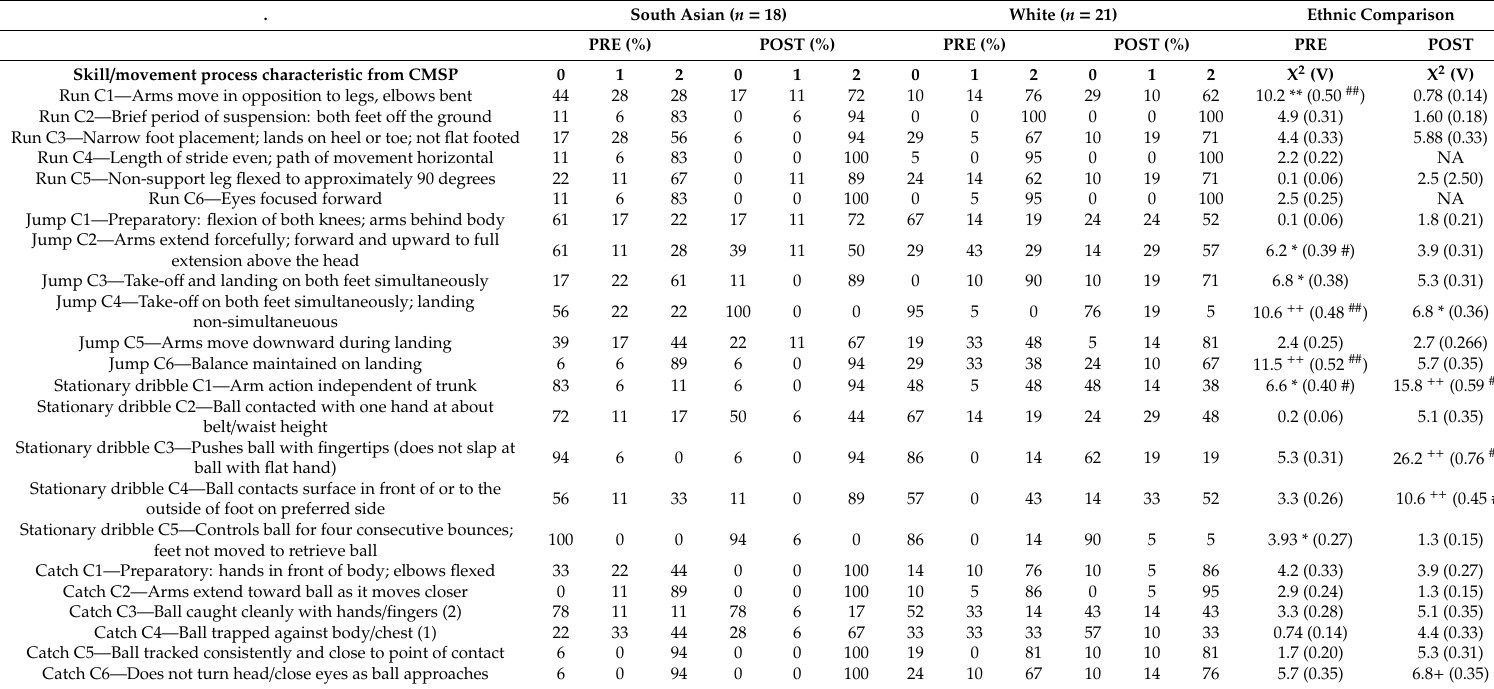
Table 5. Percentage of children at poor, near mastery, and mastery for each movement process characteristic of the skill at pre and post. . South Asian ( n = 18) White ( n = 21) Ethnic Comparison PRE (%) POST (%) PRE (%) POST (%) PRE POST Skill / movement process characteristic from CMSP